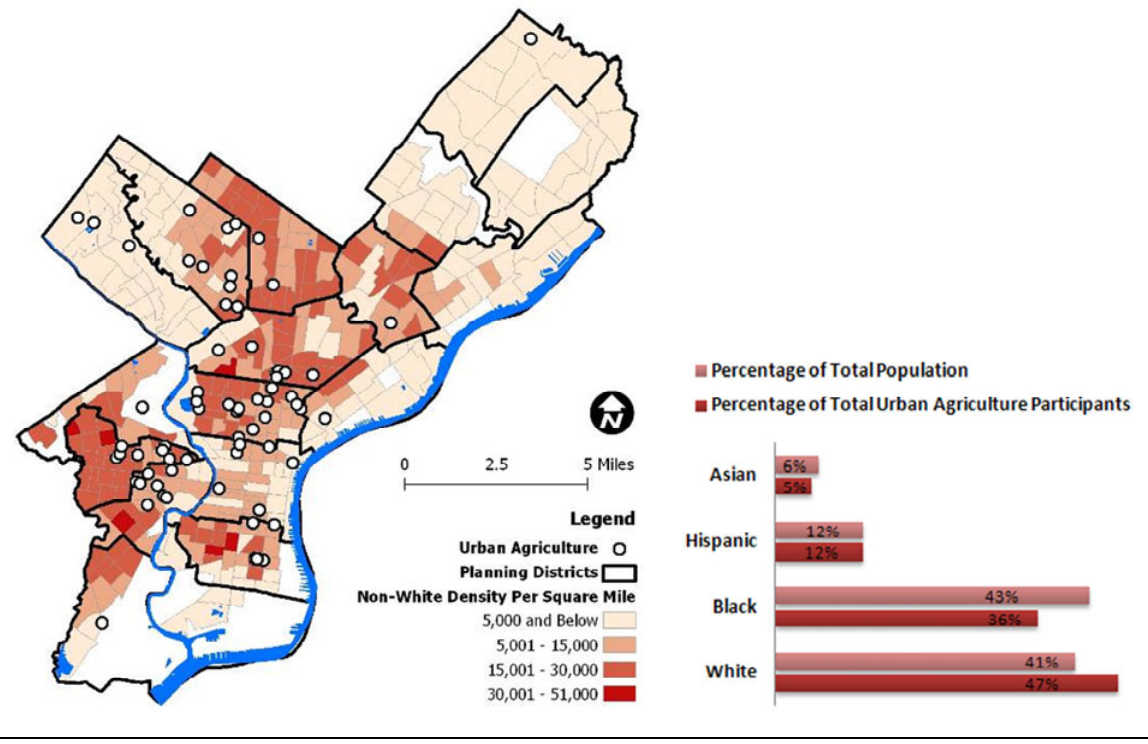
Data sources: U.S. Census; City of Philadelphia; survey by